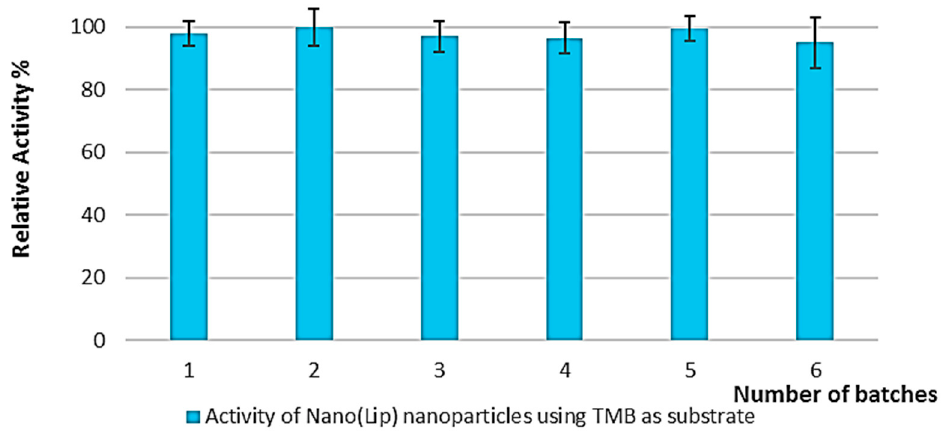
Figure 7. Activity of the nanoparticles prepared in different batches.